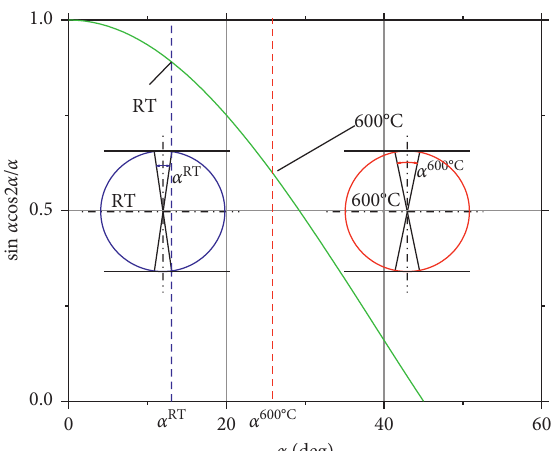
Figure 16: Variation of the correction factor ß with a contact angle a (the blue circle and the red circle represent the untreated sandstone and 600 ° C treated sandstone in the Brazilian split test α 600 ° C > α RT